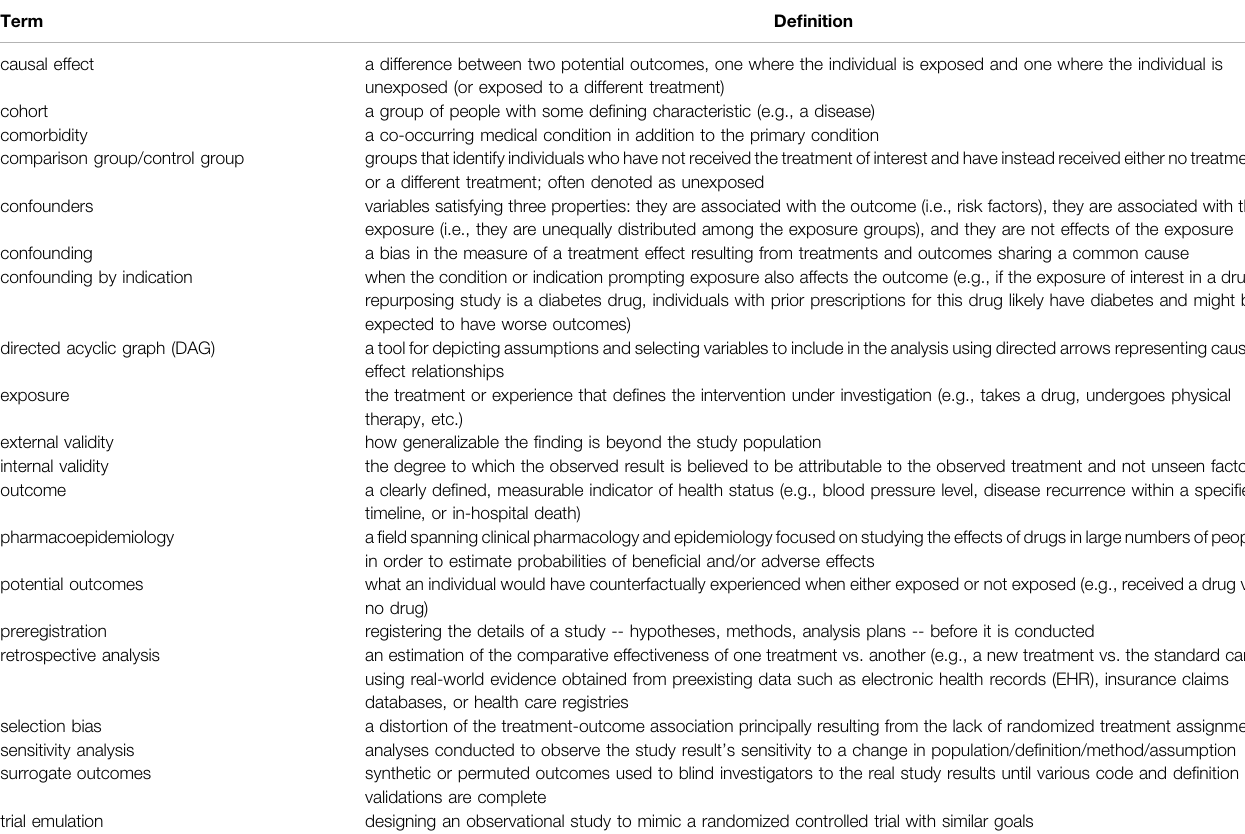
TABLE 1 | This table of common terms provides working de fi nitions for vocabulary appearing in the following 10